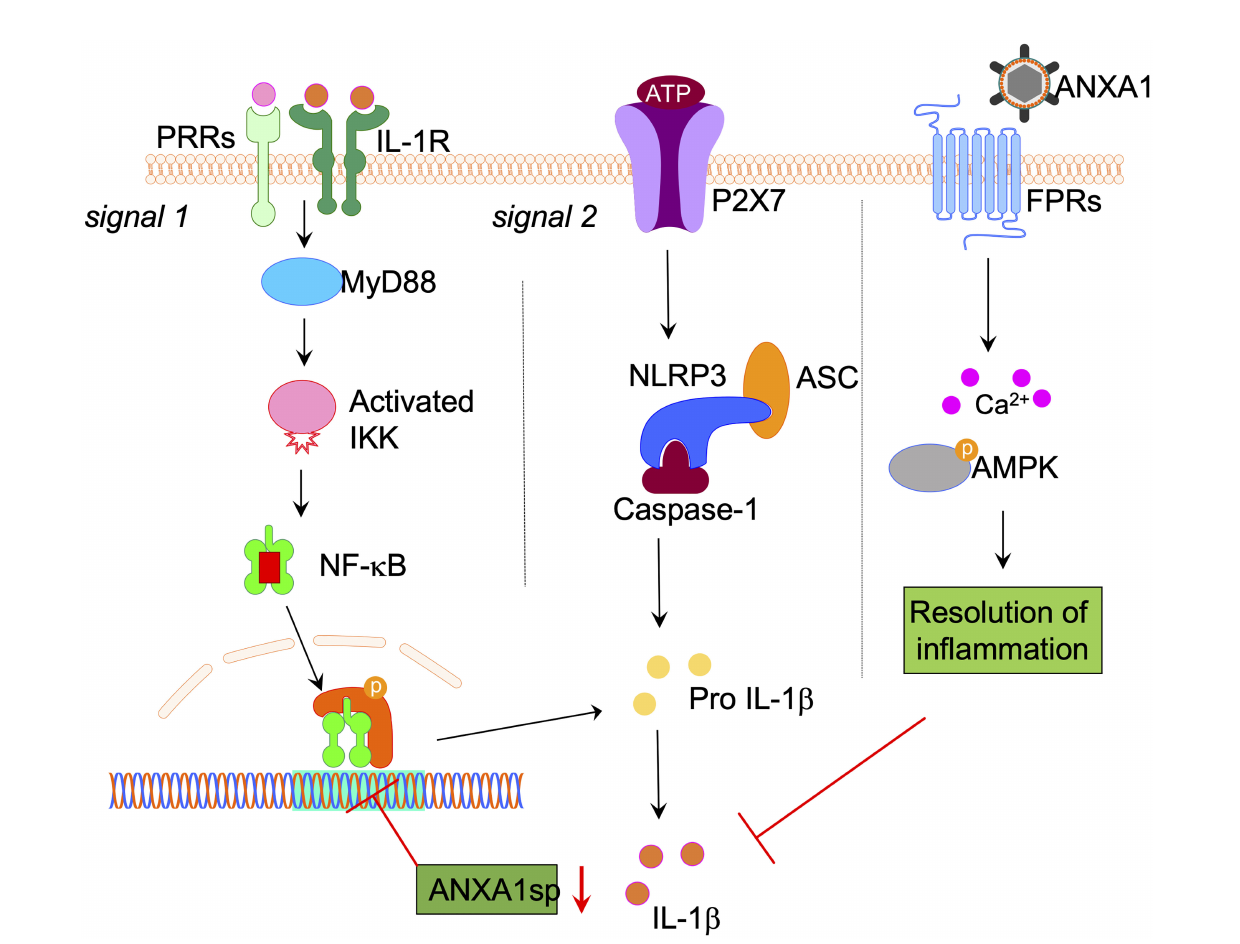
FIGURE 7 | Proposed NLPR3 signaling mechanism in postoperative neuroin fl ammation. Aseptic surgical trauma induces a cytokine storm that engages several pattern recognition receptors (PRRs), including the interlukin-1 (IL-1) receptor. Downstream signaling from these receptors relies on adaptor proteins such as MyD88, which eventually activates NF- k B to perpetuate the in fl ammatory response. Parallel to this process, surgery also elevated levels of ATP in the hippocampus. In combination with NF- k B activation this induced the NLRP3 in fl ammasome and ASC specks formation in microglia, thus contributing to postoperative neuroin fl ammation. Surgery also impaired the expression of hippocampal Annexin-A1 (ANXA1) that is critically involved in in fl ammation-resolution and can be regulated through our biomimetic peptide. Within this framework we found that treatment with ANXA1sp regulated NLRP3 expression and levels of IL-1 b postoperatively. Given the established elevation of IL-1 b in preclinical and clinical bio fl uids of subjects with postoperative neurocognitive disorders, harnessing this pathway may provide safer strategies to treat ensuing neuroin fl